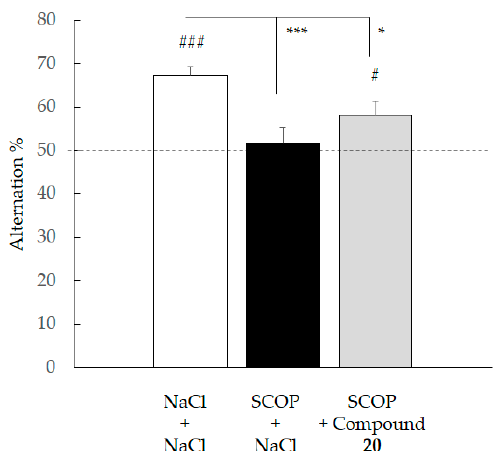
Figure 8. Effect of compound 20 on scopolamine impairment during the spontaneous alternation test. Data are expressed as the mean ± standard deviation (SEM, n = 8–10 per group) NaCl and compound 20 (1 mg/kg) were administered IP 30 minutes before the test, scopolamine (SCOP, 0.5 mg/kg)) was administered SC 20 minutes before the test. (# p < 0.05, ### p < 0.001 versus 50%; univariate t -test). (* p < 0.05, *** p < 0.001 versus other groups, SNK test).